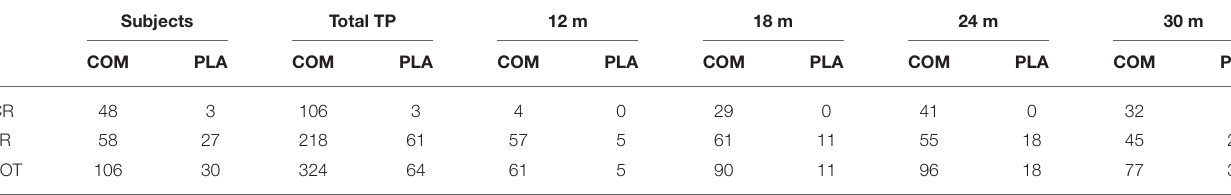
TABLE 1 | Number of subjects at each time point (TP) are divided into completed (COM) and planned (PLA) protocol. Subjects Total TP 12 m 18 m